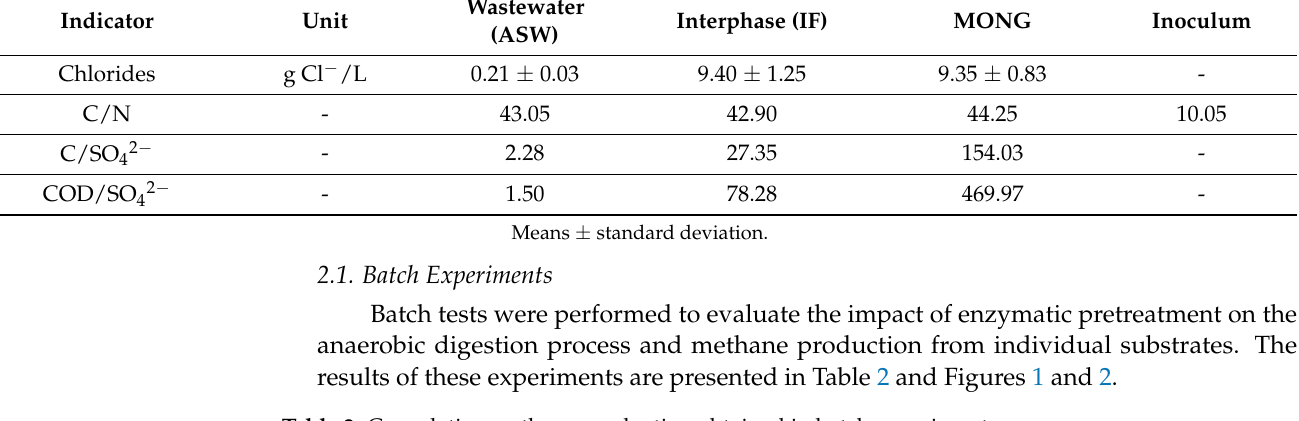
Table 2. Cumulative methane production obtained in batch